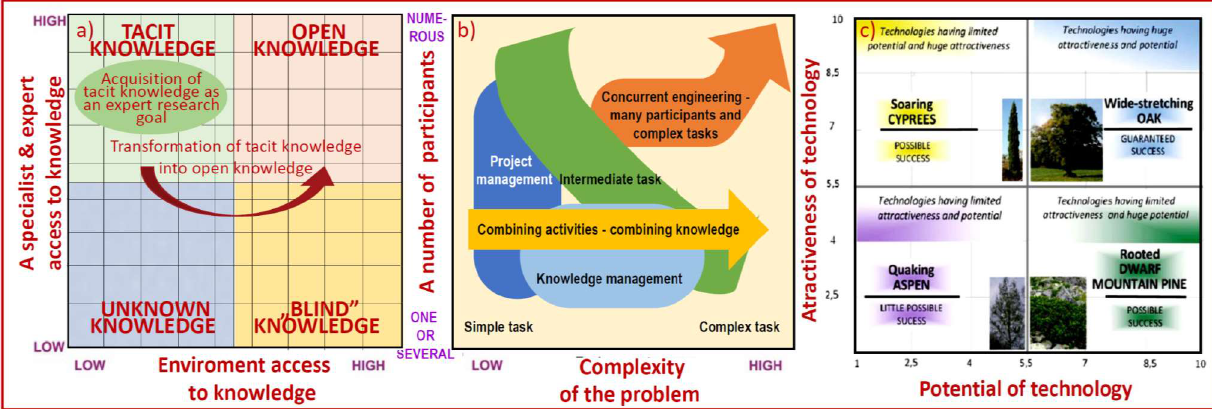
Figure 7. Schemes of context matrices: ( a ) knowledge availability; ( b ) dependence of the complexity of the problem to be solved on the number of participants in concurrent engineering; ( c ) dendrological value of technology—presentation of the approach.